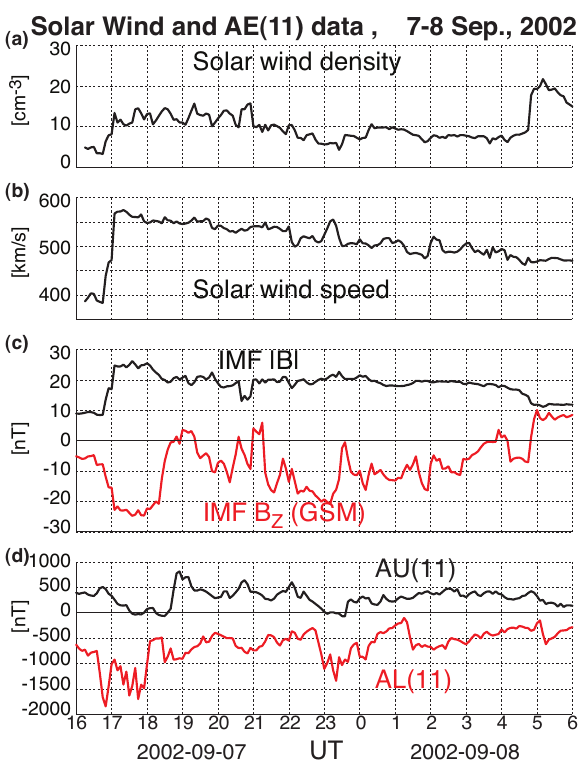
Fig. 4. The same as Fig. 2 but for 7–8 September 2002.